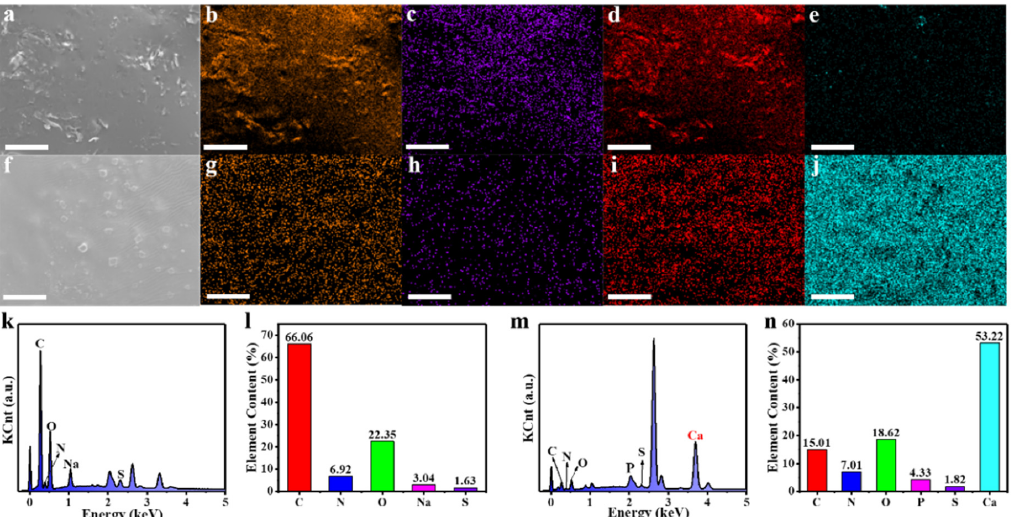
Figure 5. SEM images of FNs ( a ) and FNs − Ca(II) ( f ). Distribution diagram of C ( b ) for FNs and ( g ) for FNs − Ca(II); N ( c ) for FNs and ( h ) for FNs − Ca(II); O ( d ) for FNs and ( i ) for FNs − Ca(II); and Ca ( e ) for FNs and ( j ) for FNs − Ca(II). EDS spectrum of FNs ( k ) and FNs − Ca(II) ( m ), and element statistics of FNs ( l ) and FNs − Ca(II) ( n ). Scale bar is 50 μ m.